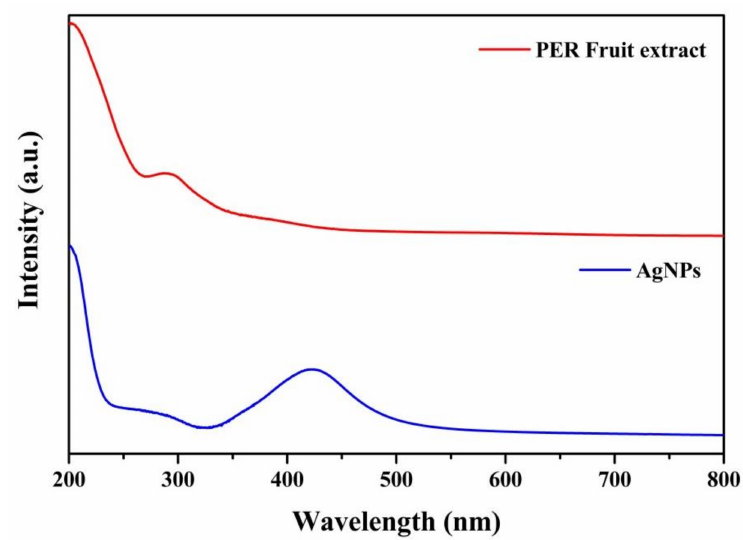
Figure 5. UV–visible spectra of (red curve) PER fruit extract and (blue curve) Ag-NPs synthesized by using phytochemical agents present in the Phyllanthus reticulatus fruit extract. The peak at 422 nm corresponds to the surface plasmon resonance of